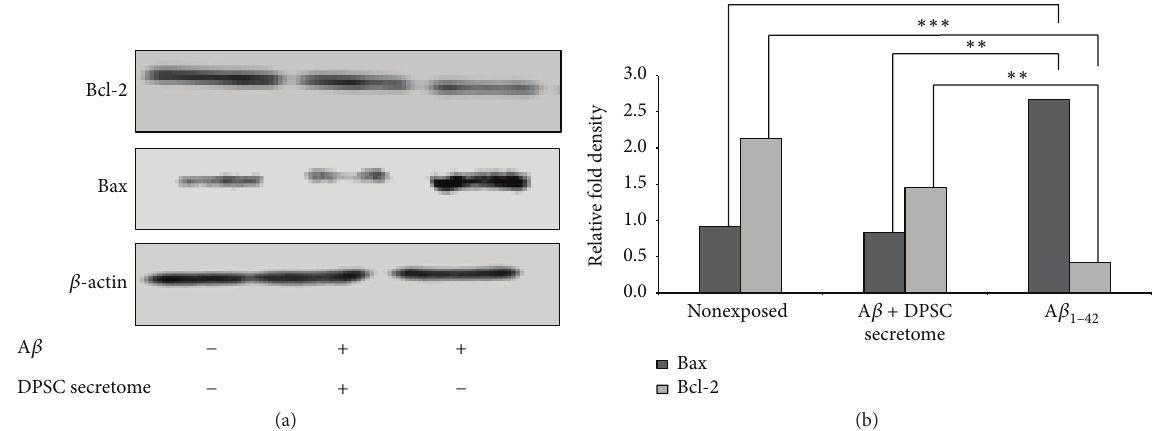
Figure 4: DPSC secretome stimulates the endogenous survival factor Bcl-2 and decreases the apoptotic regulator Bax. (a) Immunoblotting analysis with an anti-Bax, an anti-Bcl2, or an anti-actin antibody (full-length blots are presented in Supplementary Figure S2). (b) Relative fold density as analyzed by Image J (mean ± SE, 𝑛 = 3 . ∗∗ 𝑝 < 0.01 , ∗∗∗ 𝑝 < 0.001 ).